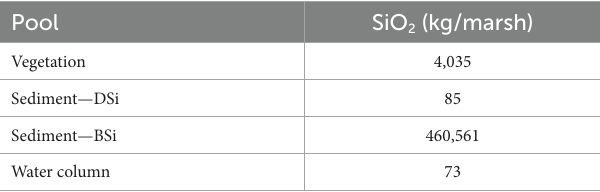
TABLE 1 Estimated Si pools for the Cell 1B tidal marsh (11.22 ha) at Poplar Island, Chesapeake Bay, including macrophyte vegetation, sediment root zone (top 15 cm), and tidal creek water volume in 2014.